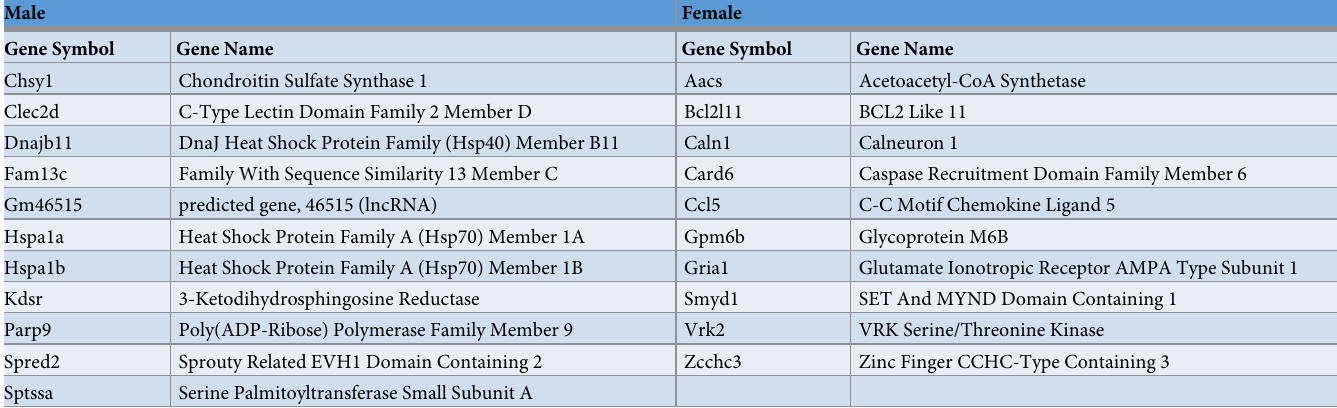
Table 3. Genes Differentially Expressed between CIE and Air C57Bl/6J Mice in Hypothalamus with Expression Levels that are also Correlated between Blood and Hypothalamus. Male Gene